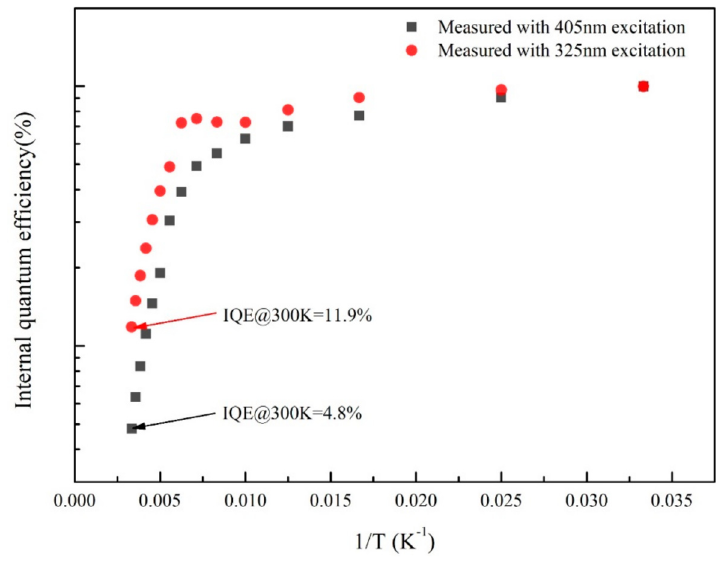
Figure 7. The trend of internal quantum efficiency of sample 2QW under different wavelength excitation